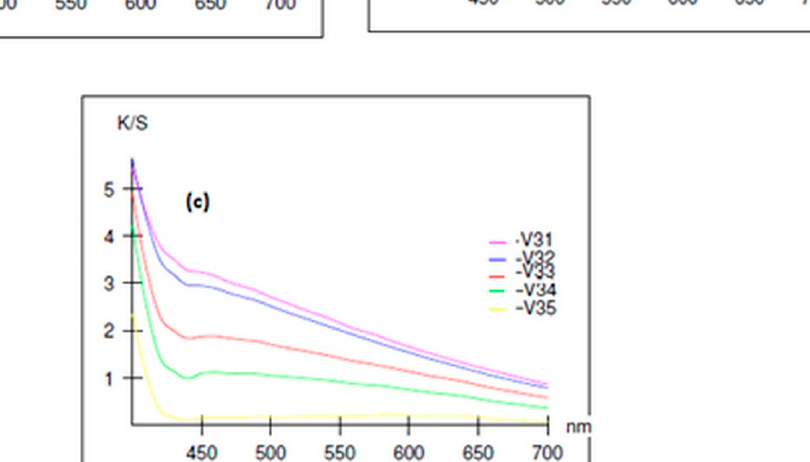
decreased with the increase in the polymeric fibre content used as matrices.